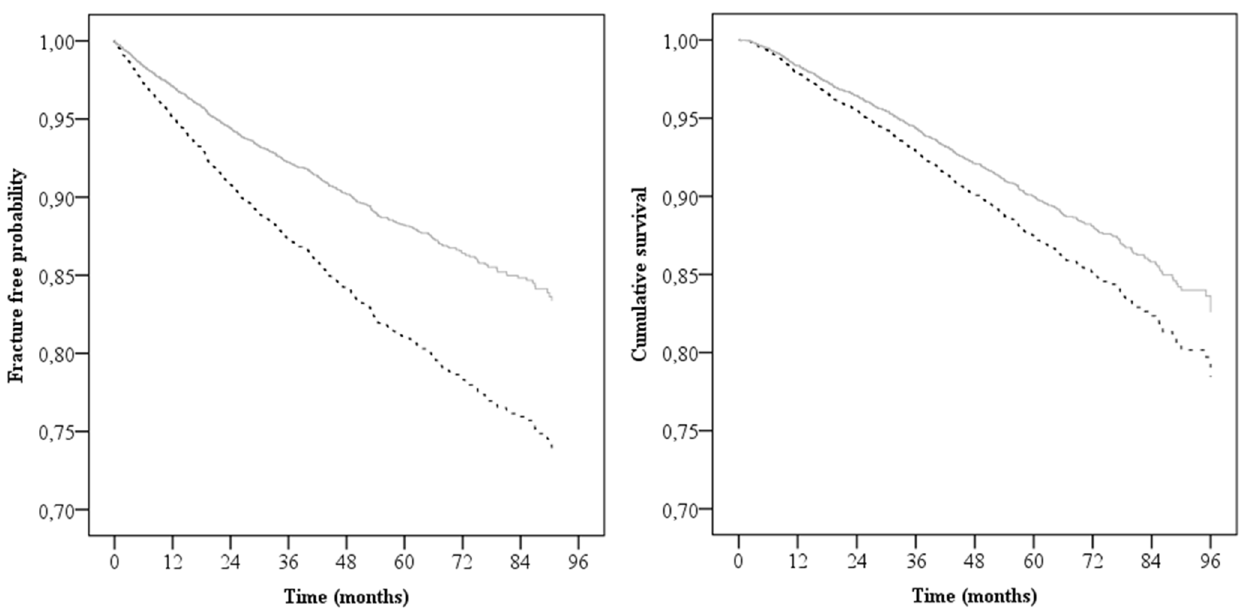
Fig 2. Survival curves for subsequent fractures and mortality. The curves are based on multivariable Cox proportional hazard models for subsequent fractures and mortality expressed as (A) fracture-free probability and (B) cumulative survival. Results presented for vitamin D and calcium recommendation alone (dotted black) and for bisphosphonates plus calcium and vitamin D recommendation (solid grey).